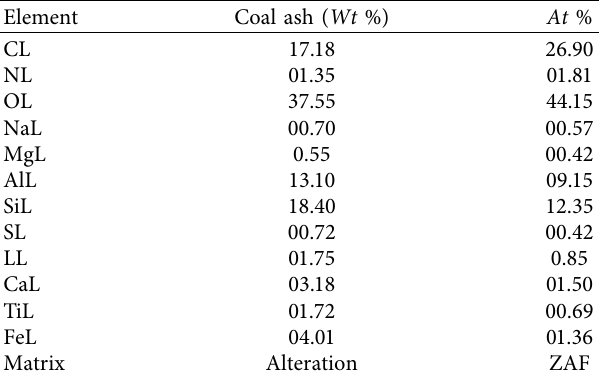
Table 1: Features of coal